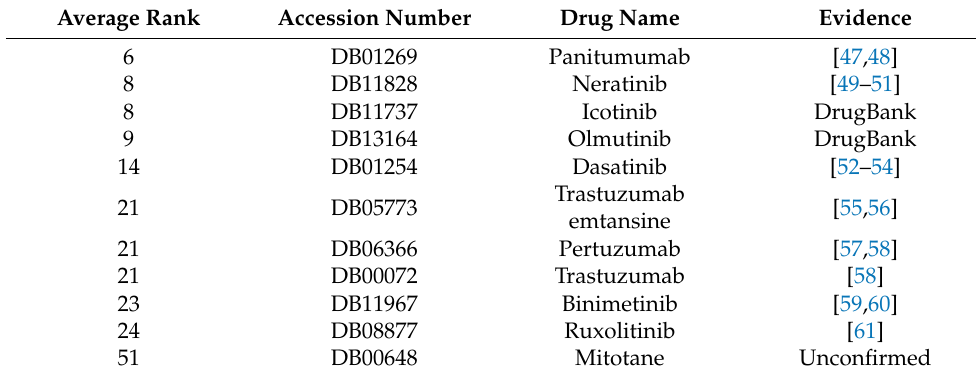
Table 1. The potential repurposed